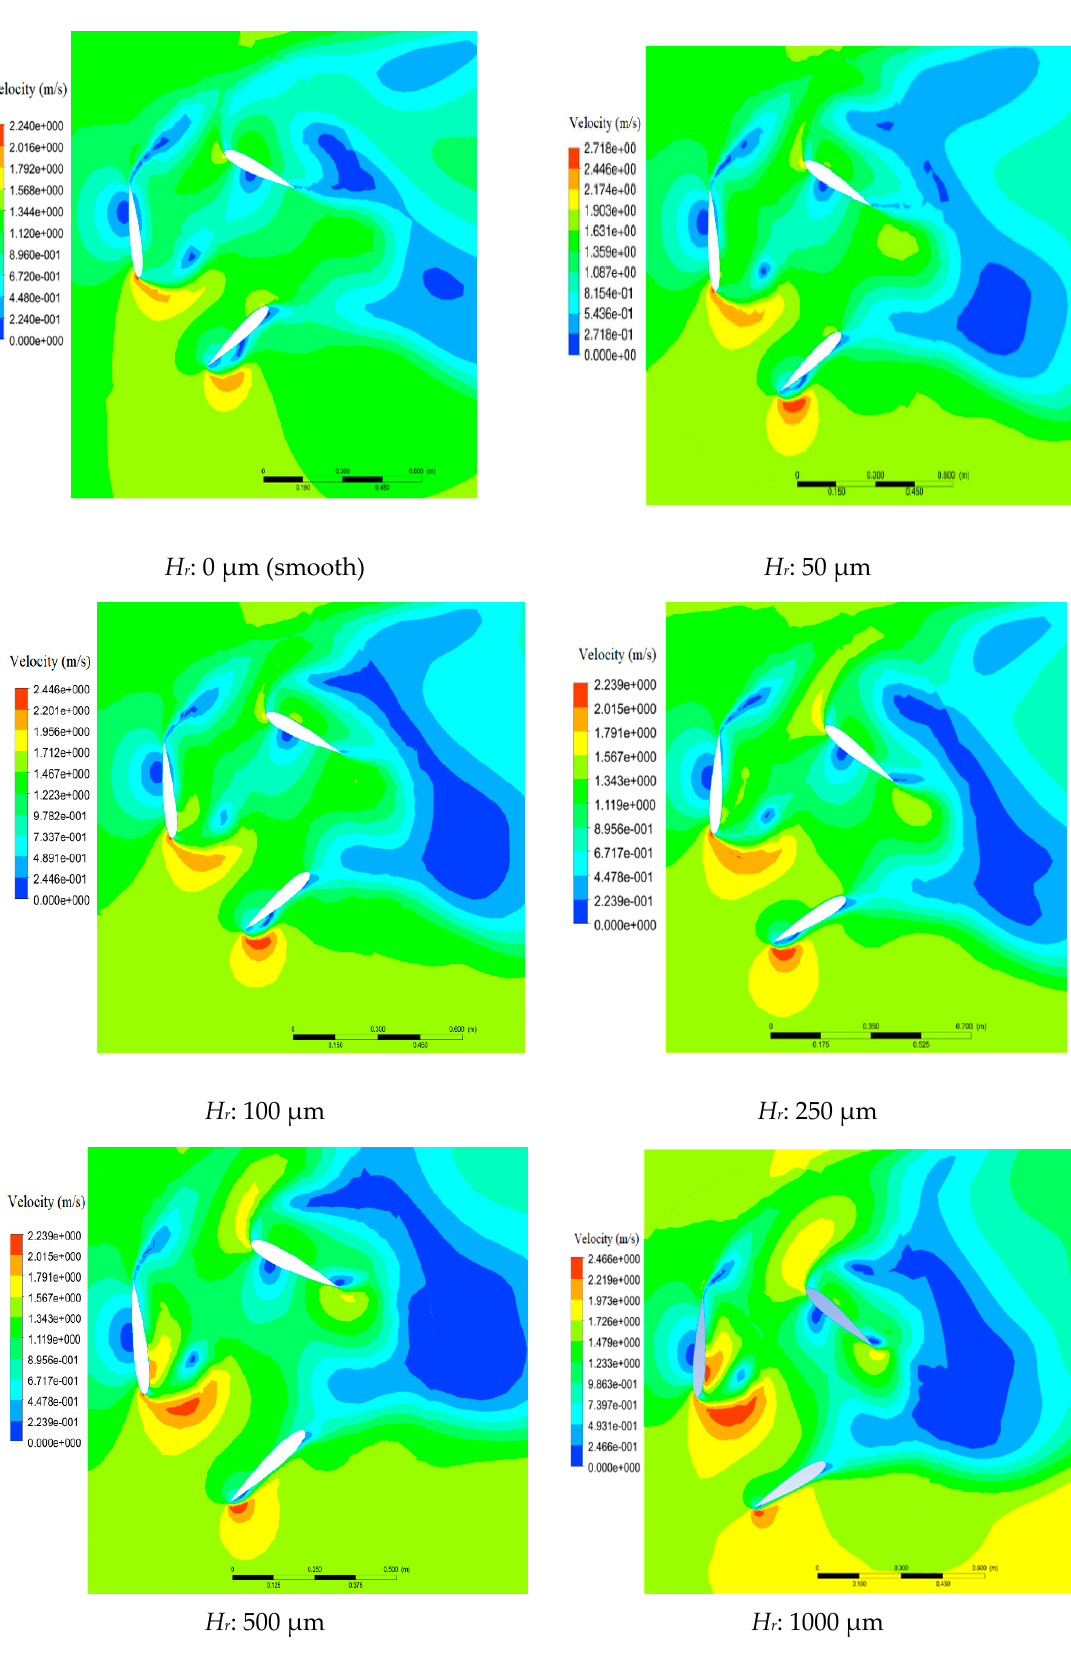
Figure 9. Distribution of velocity for various roughness heights on NACA 0015 airfoil at ζ = 1.5.